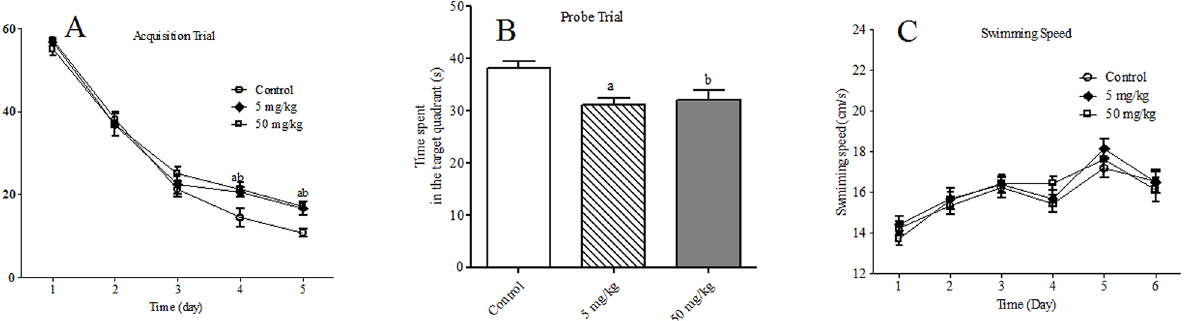
Fig 3. The effects of TDBP-TAZTO (5 and 50 mg/kg) on spatial learning and memory in rats in the Morris water test. (A) In the acquisition trial, TDBP-TAZTO rats showed an increased latency to the platform. (B) In the probe trial, TDBP-TAZTO rats had a decreased time spent in the target quadrant. (C) From day 1 to day 6, TDBP-TAZTO did not affect the swimming speed compared with that in control group. Data ate expressed as mean ± SE (n = 10/ group). a p < 0.05, TDBP-TAZTO 5 mg/kg group vs. control group; b p < 0.05, TDBP-TAZTO 50 mg/kg group vs. control group.